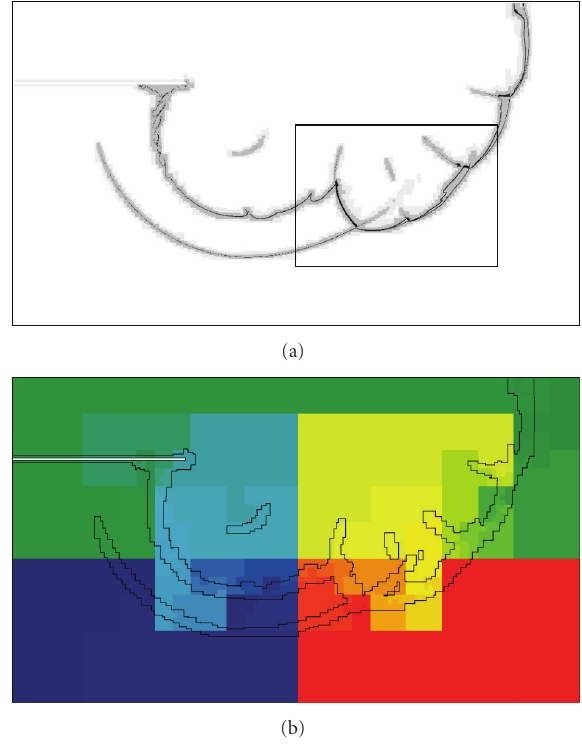
Figure 18: Density distribution on refinement levels after the detonation has left the tube (a) and distribution of computational domain to 48 CPUs (b) for 10 λ .